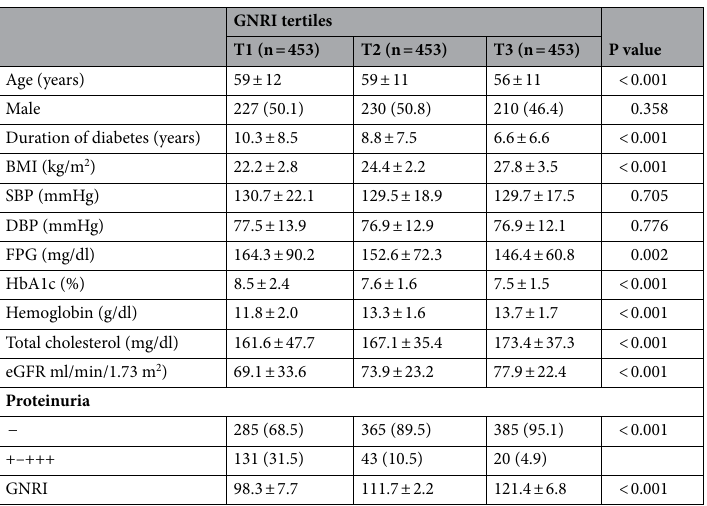
Table 2. Comparison of clinical and laboratory parameters by GNRI tertiles. Data are expressed as mean ± standard deviation and number (percent). DR, diabetic retinopathy; NPDR, non-proliferative diabetic retinopathy; PDR, proliferative diabetic retinopathy; BMI, body mass index; SBP, systolic blood pressure; DBP, diastolic blood pressure; FPG, fasting plasma glucose; Hemoglobin A1c, HbA1c; eGFR, estimated glomerular filtration rate; GNRI, geriatric nutritional risk index.